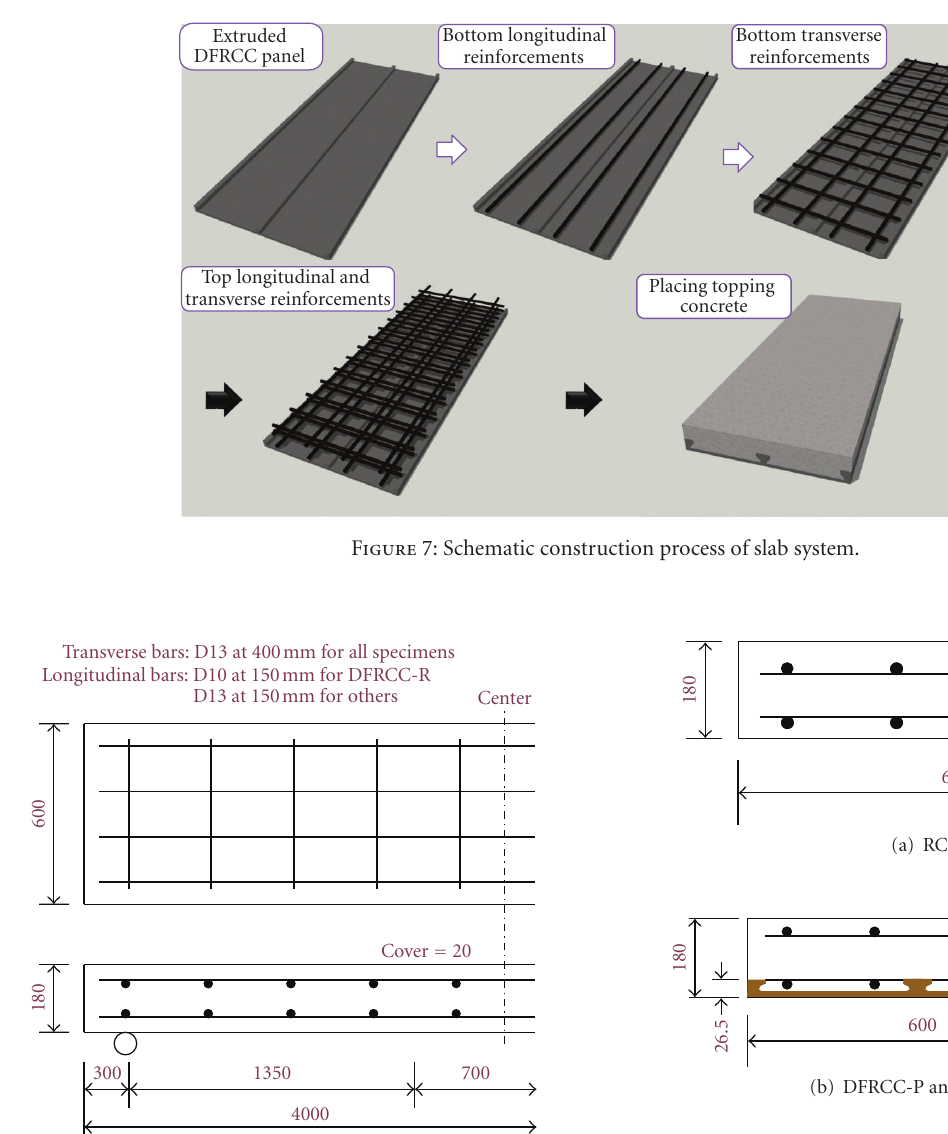
Figure 9: Cross-section of slab